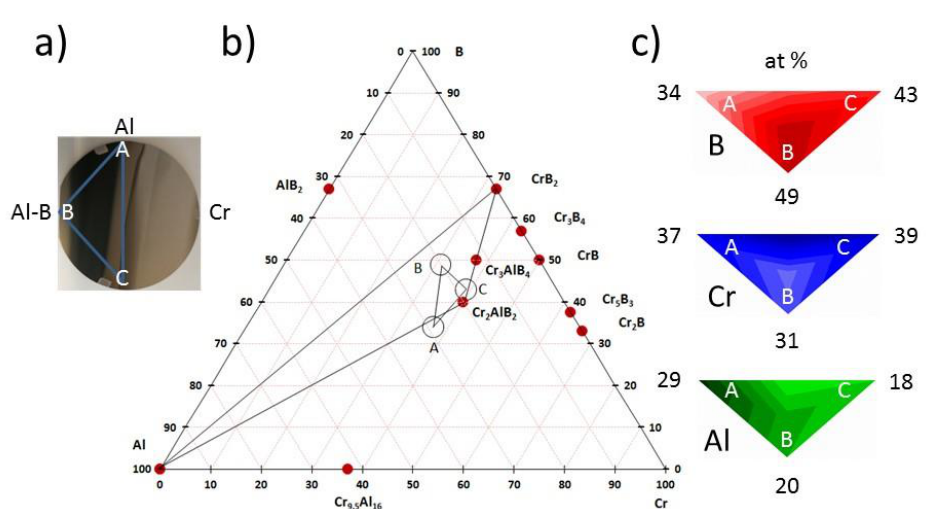
Figure 2. ( a ) Image of the Si wafer with a compositional gradient with labels showing where the XPS analyses were performed and the orientation of the targets. ( b ) Ternary Cr-Al-B section with known binary and ternary phases (adapted from [15]) marked with red dots. The analysis spots are marked with circles and Al, CrB 2 and Cr 2 AlB 2 compositions are joined by lines. ( c ) Measured compositions in the Cr-Al-B gradient at points A, B and C in at.%. The vertex pointing down shows the composition at point B, while the vertices to the left and right show compositions A and C, respectively.